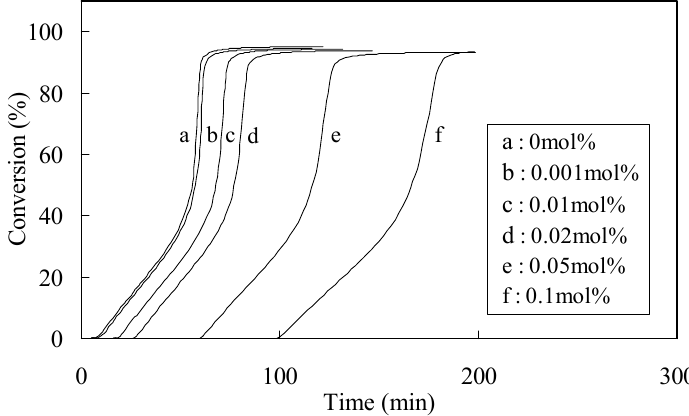
Figure 2. Time-conversion curves for the polymerization of MMA with BPO in the presence of